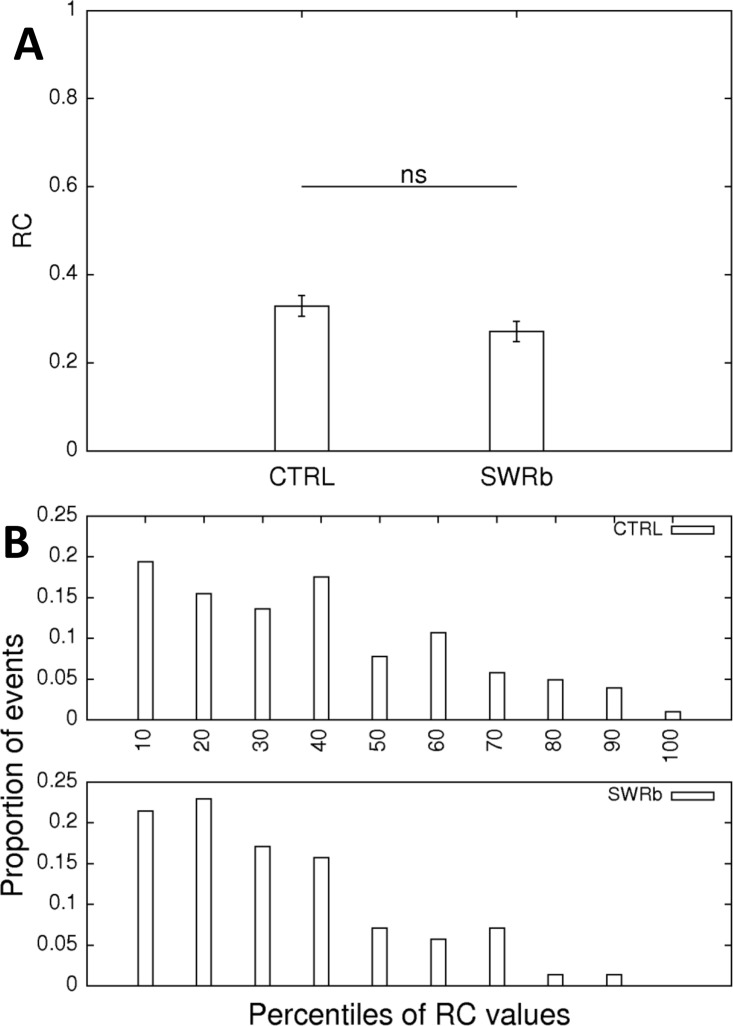
Changes of the average firing rates of the cells.(A) Firing rate changes (RC) between the first and second exploration of the same environment according to the formula defined in the text, on control days (left bar) and SWR-blockade days (right bar). The difference between the two RC values is not significant (p = 0.092, Oneway ANOVA). (B) The distribution of such changes is shown as a histogram in decimal steps along all possible rate change values. The two distributions are not significantly different (Kolmogorov-Smirnov test; p = 0.179; D = 0.167). 117 (SWR block) + 116 (CTRL) pyramidal cells were used for this analysis.